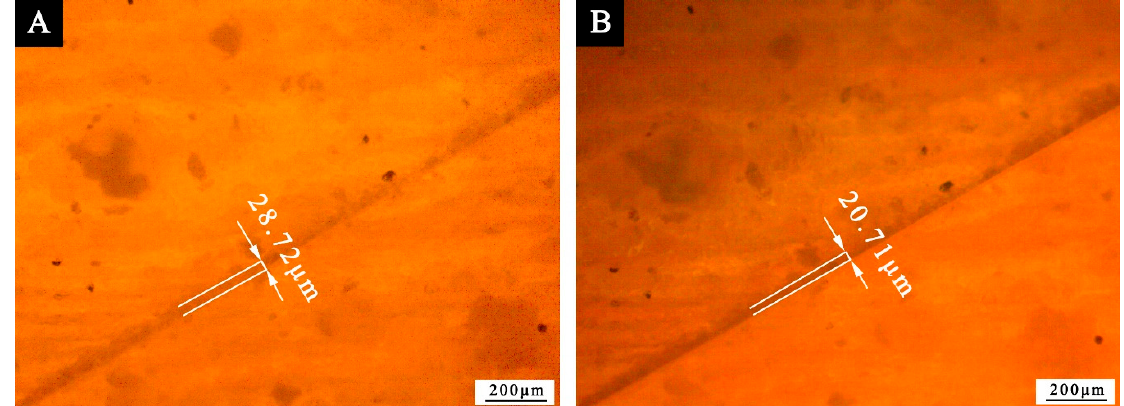
Figure 11. The OM diagram of paint coating with 10.0% microcapsule: ( A ) 0 d, ( B ) 5 d.